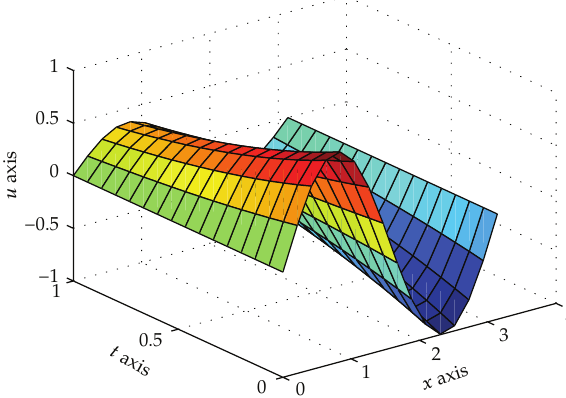
Figure 1: Exact solution of the initial-nonlocal boundary value problem (cid:4) 3.1 (cid:5)